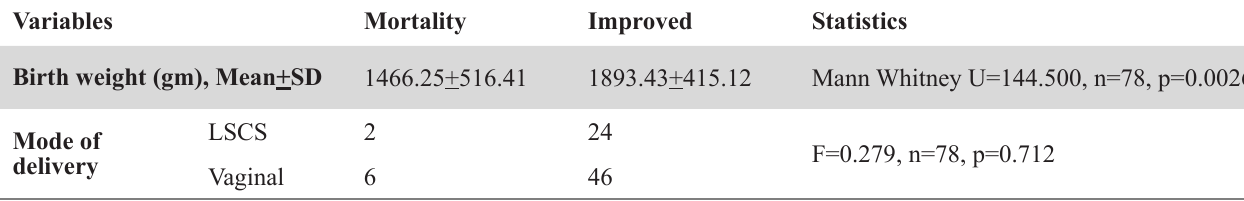
Table 4. Association of Birth Weight and Mode of Delivery with Clinical Outcome